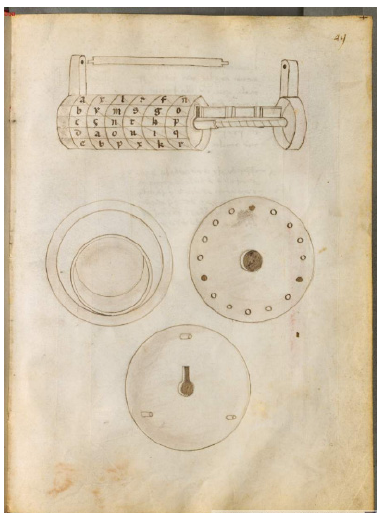
Figure 5.Parts of a lathe operated with a crank [22].